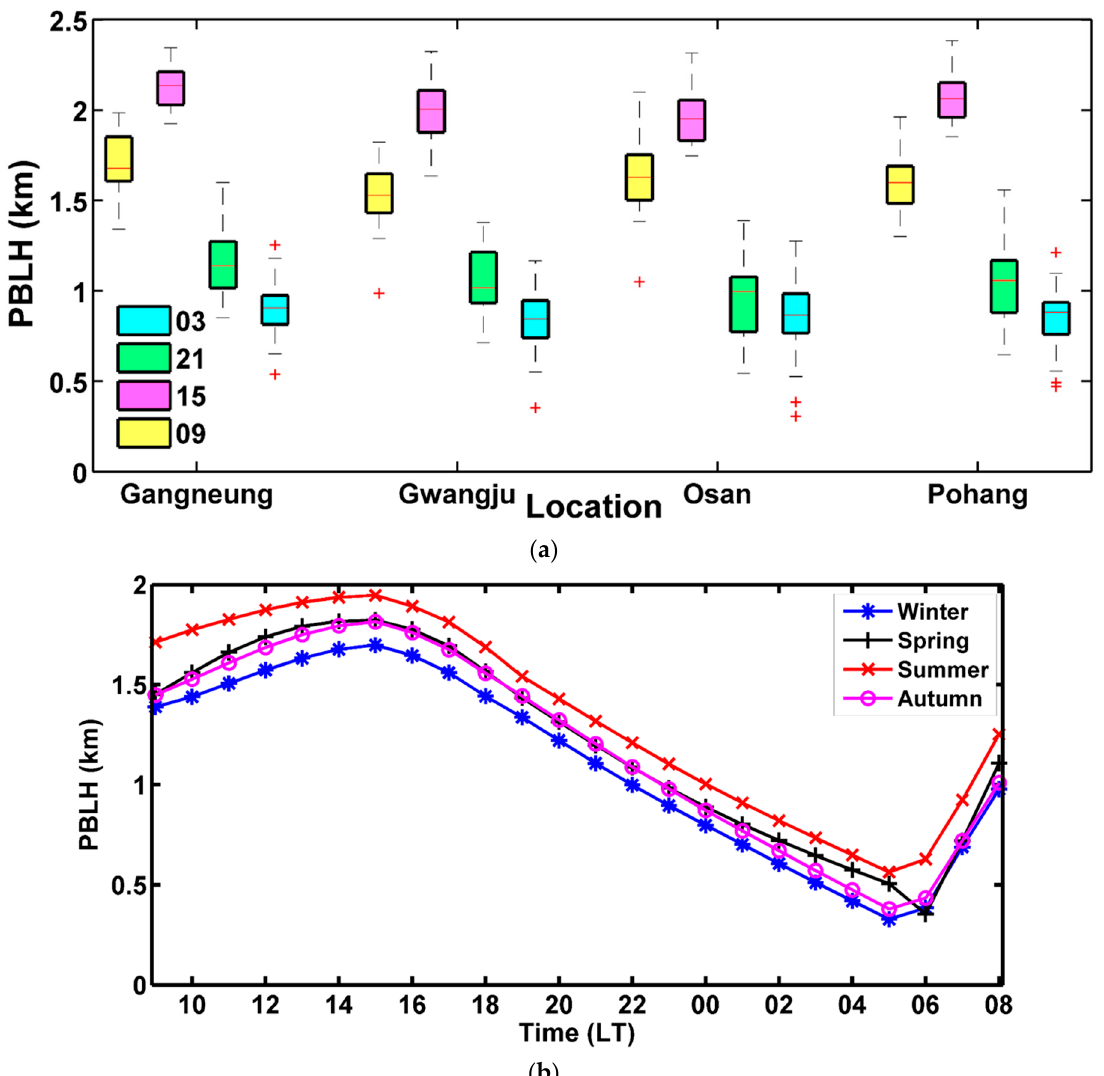
Figure 5. ( a ) Diurnal variability of the average PBLH (2008–2017) in summer for the Osan, Gwangju, Gangneung, and Pohang stations. ( b ) Diurnal and seasonal variation of the mean PBLH throughout Korean peninsula.